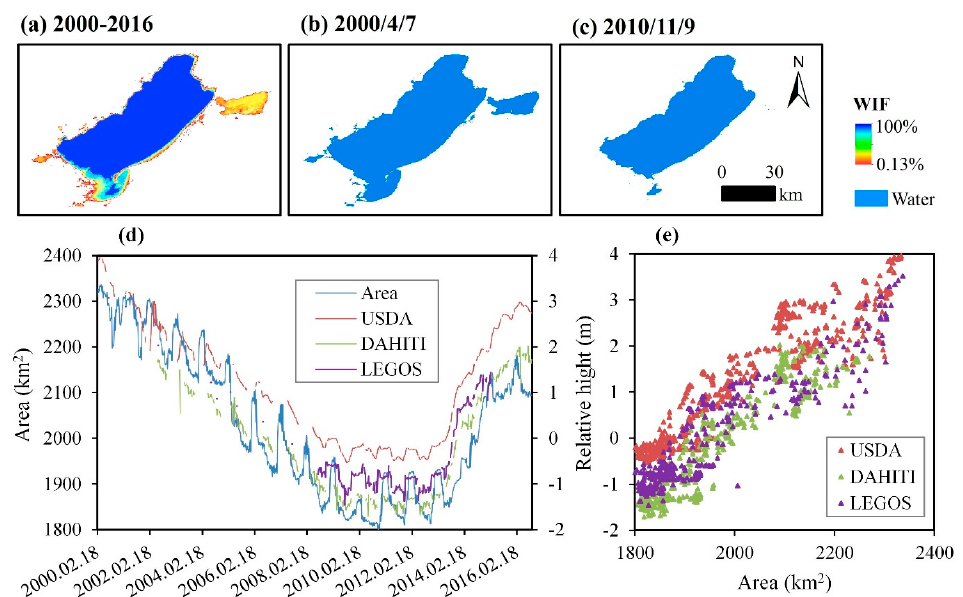
Figure 11. Spatial distribution and temporal variation of Hulun Lake. ( a ) The WIF map in 2000–2016; ( b ) water body map of 2000/4/7, with the largest water area in 2000–2016; ( c ) water body map of